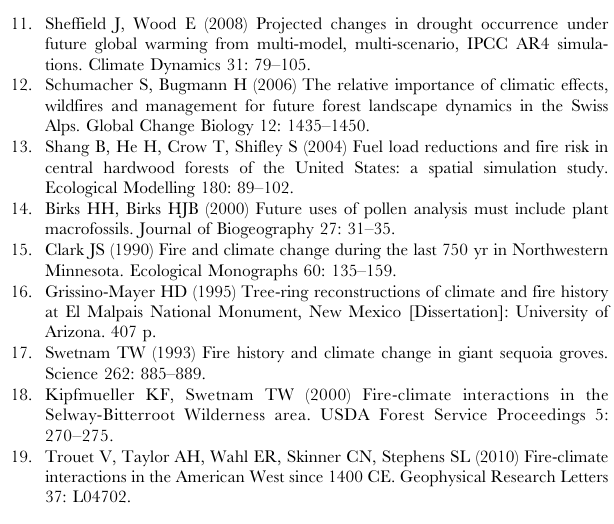
Figure S1 Location map of studied sites Found at: doi:10.1371/journal.pone.0012480.s001 (5.41 MB